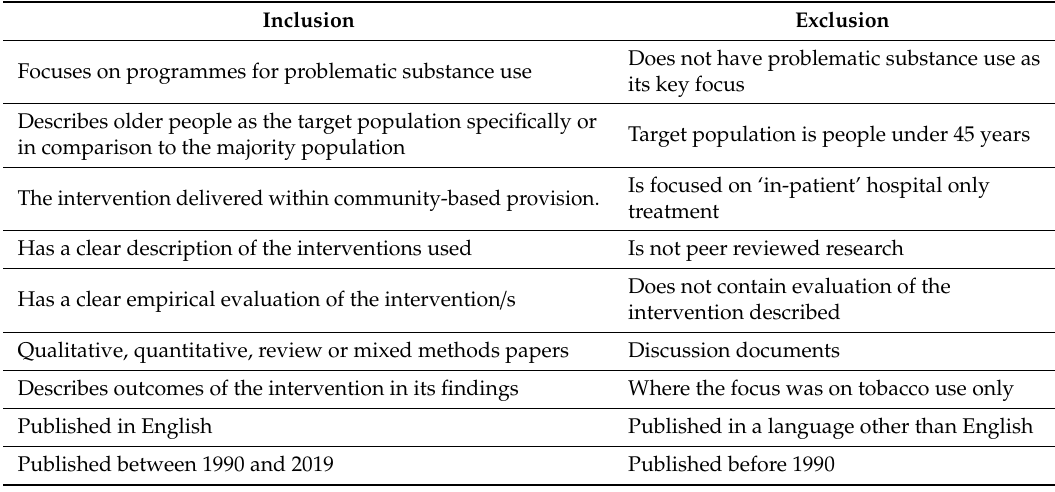
Table 2. Inclusion and exclusion